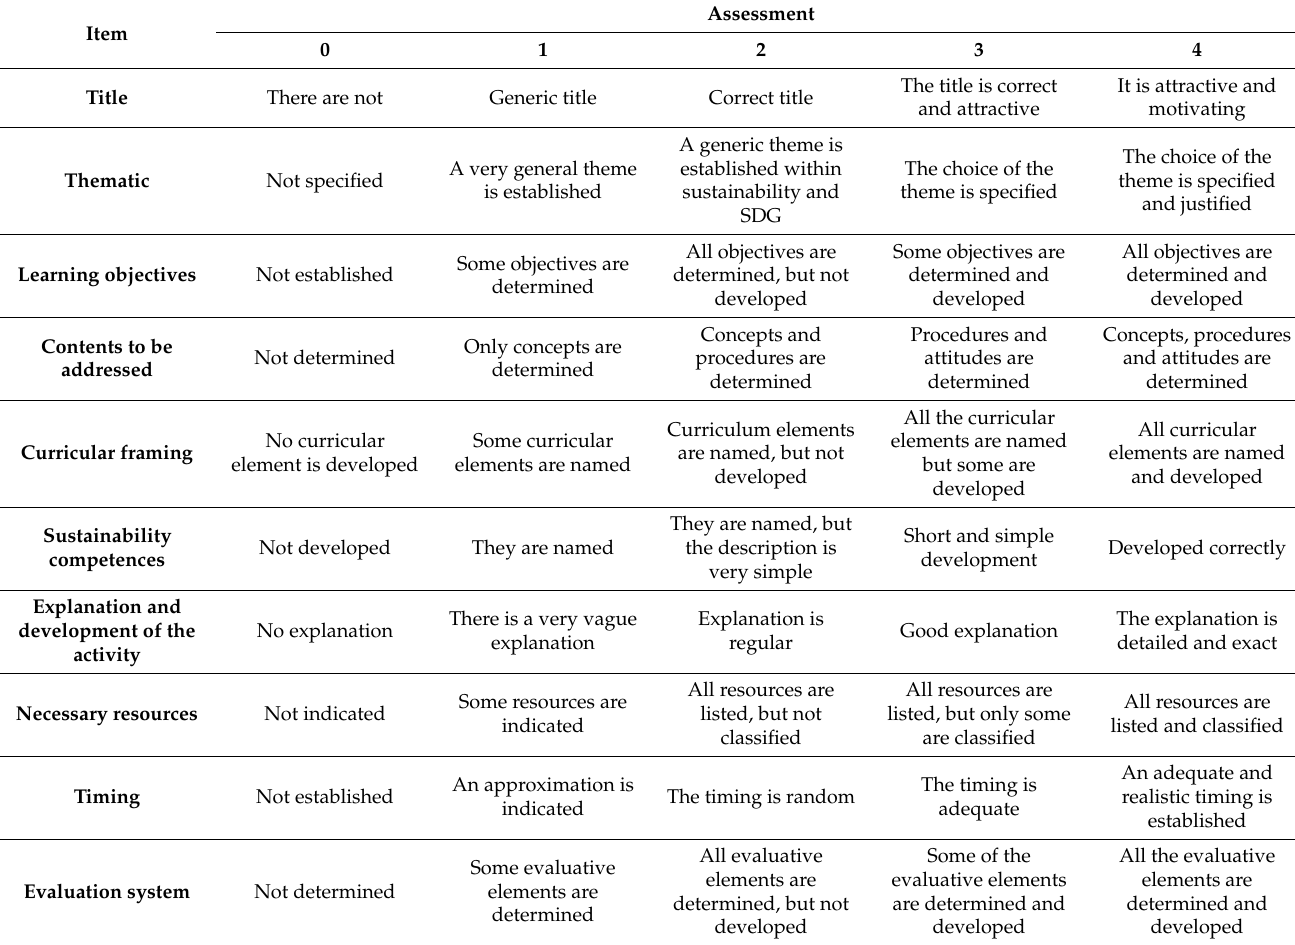
Table 1. Analysis and evaluation tool of the students’ didactic proposals. Adapted (Fern á ndez et al. 2021b; Pro and Robles 2020). Item